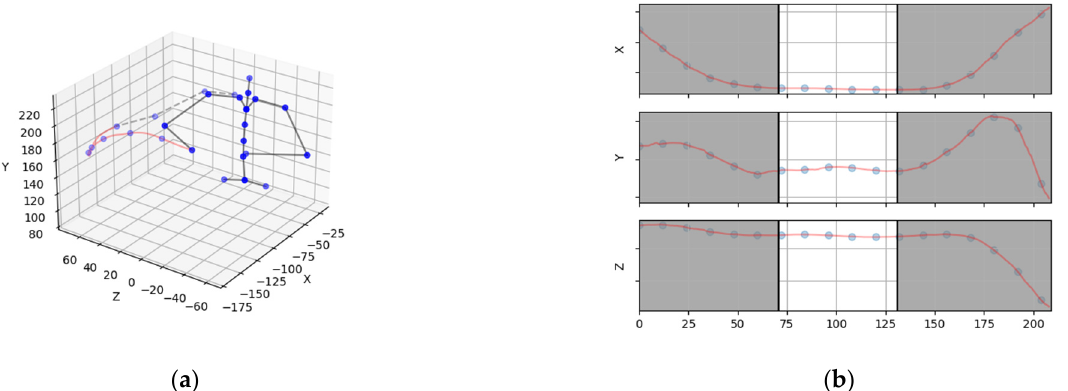
Figure 6. Image representing the skeleton data used for training the NN model and the sliding window approach: ( a ) view of the skeleton data with the points and motion data for one point (a hand motion is presented in this example); ( b ) hand motion presented as timeseries.